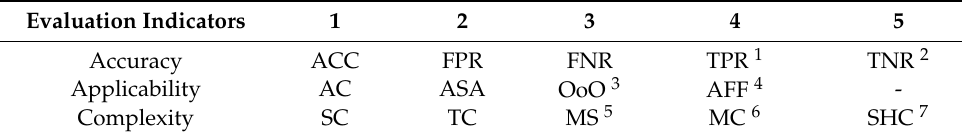
Table 8. Evaluation coefficients in